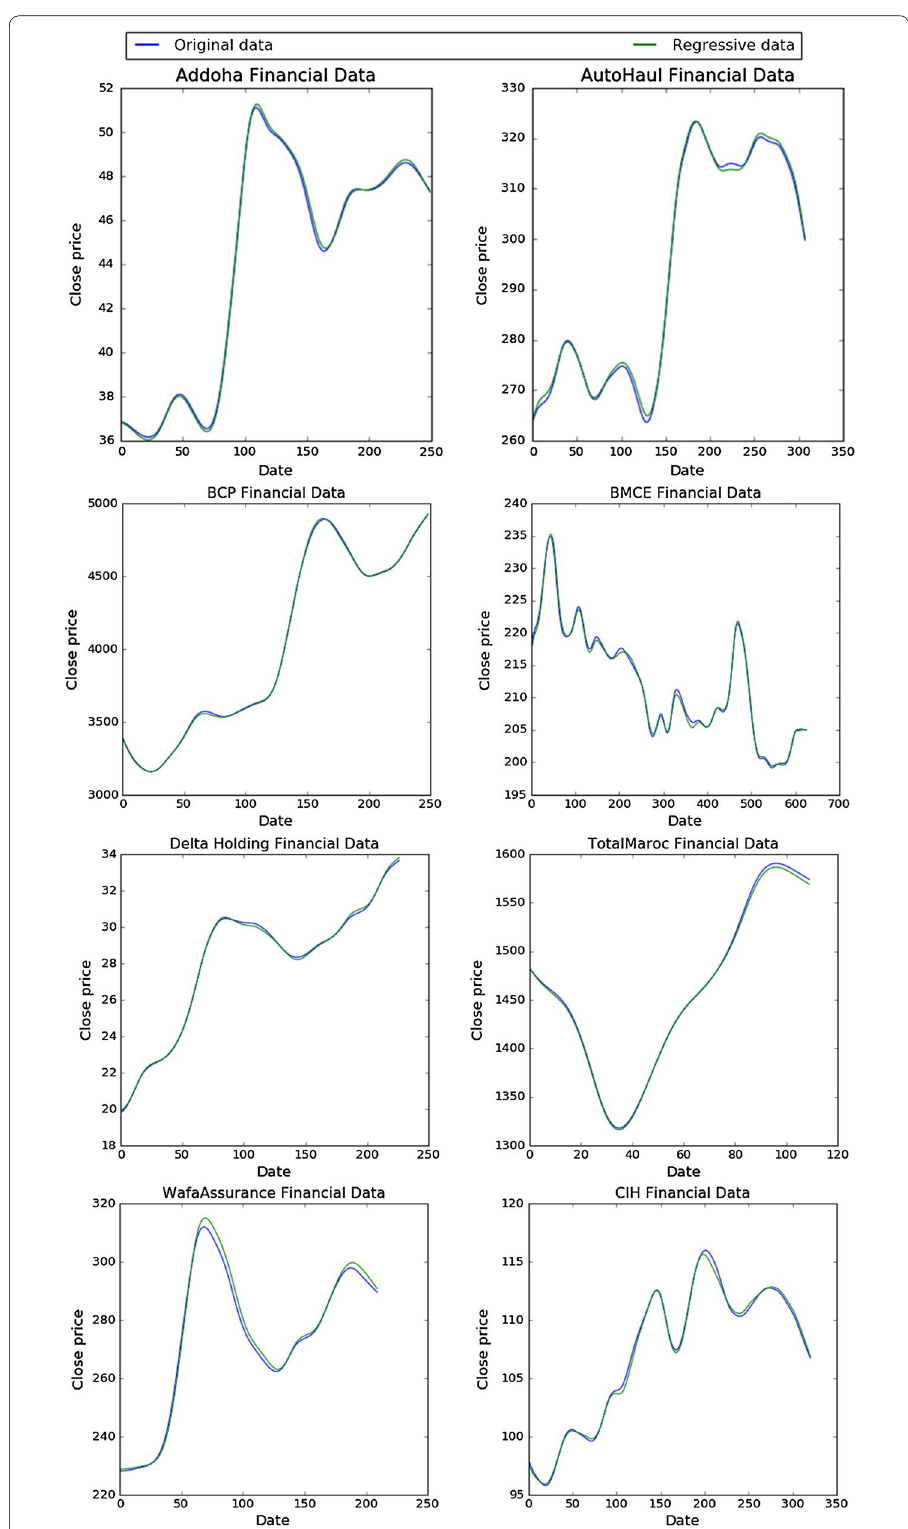
Fig. 9 Stock market price prediction: Original data VS Regressive